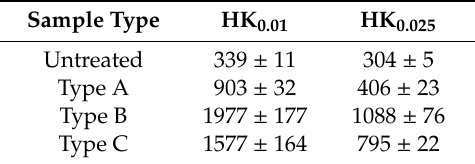
Table 3. Surface Knoop microhardness values of samples untreated and treated as indicated (test loads: 10 and 25 gf).